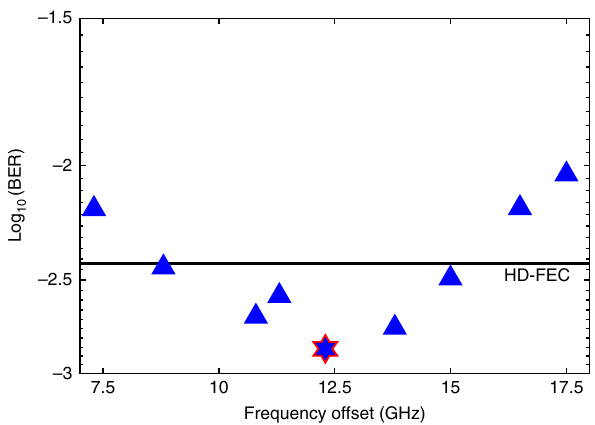
Fig. 4 Achieved BERs with respect to the frequency offset. The performance of the DS signal at − 40 dBm received power in single-channel operation vs. the frequency offset between the DS and US channels, obtained by varying the ONU laser